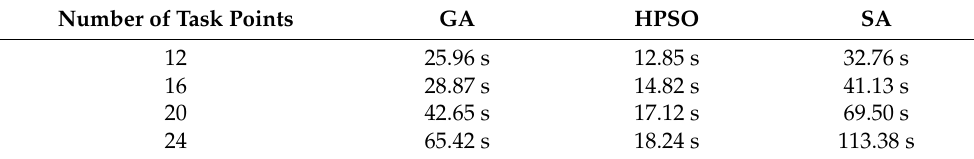
Table 15. The average execution time of the algorithm under different number of task points. Number of Task Points